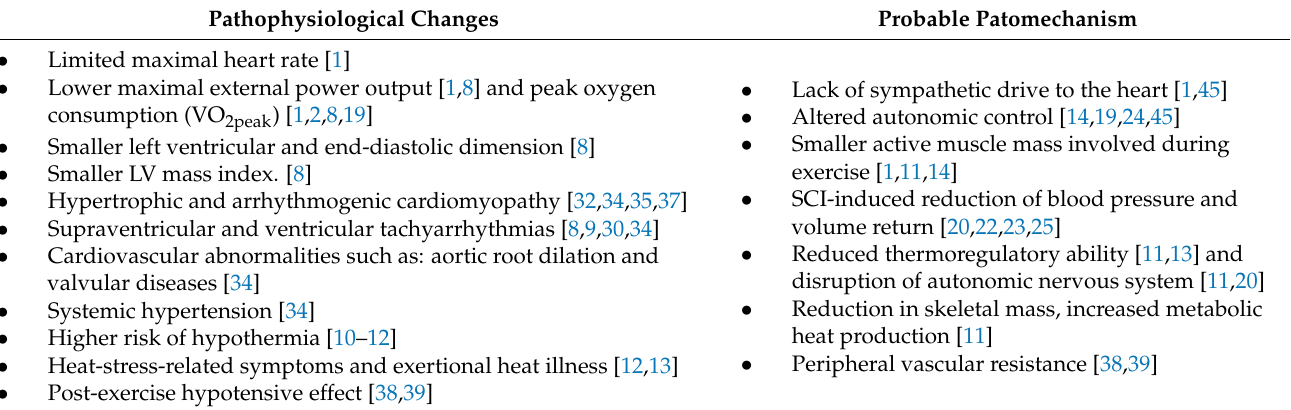
Table 2. Summary of studies on main pathophysiological changes in cardiovascular system in Paralympic